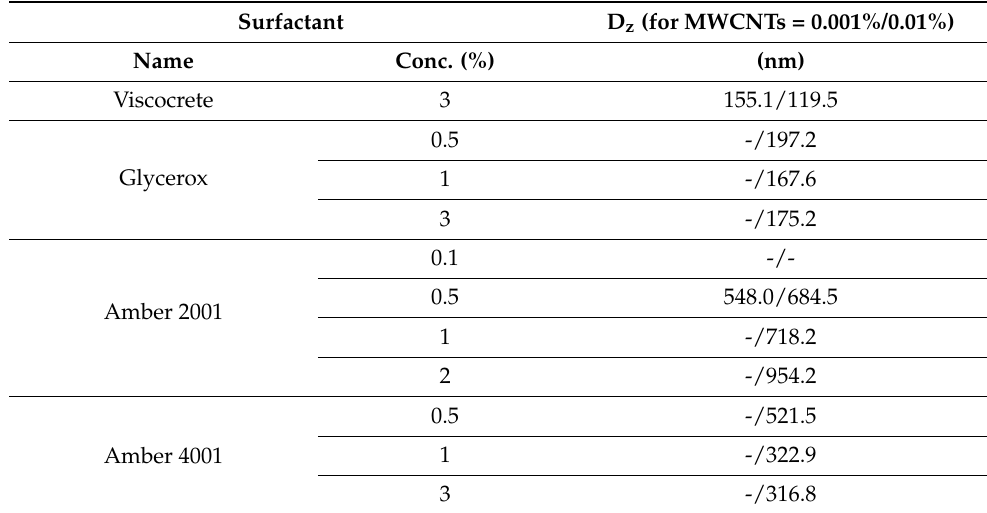
Figure 9. Strength improvement factor (for samples with 7 curing days) for the stabilized soil with MWCNT suspensions for the surfactants studied, applied in different concentrations. Table 4. Dispersion characterization of MWCNTs